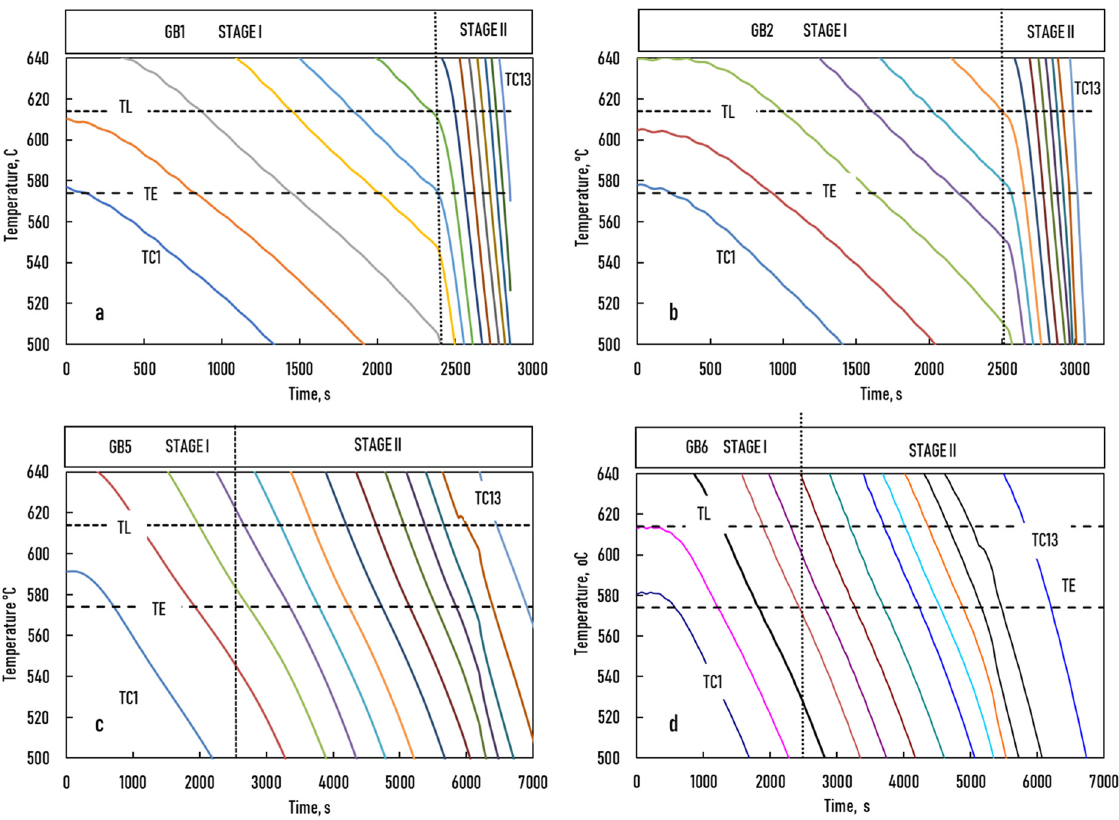
Figure 3. The measured cooling curves at different places by TC1 – TC13 thermocouples of the four ground experiments ( a ): GB1, ( b ): GB2, ( c ): GB5, ( d ): GB6. The different colours mean the data measured by different thermocouples.